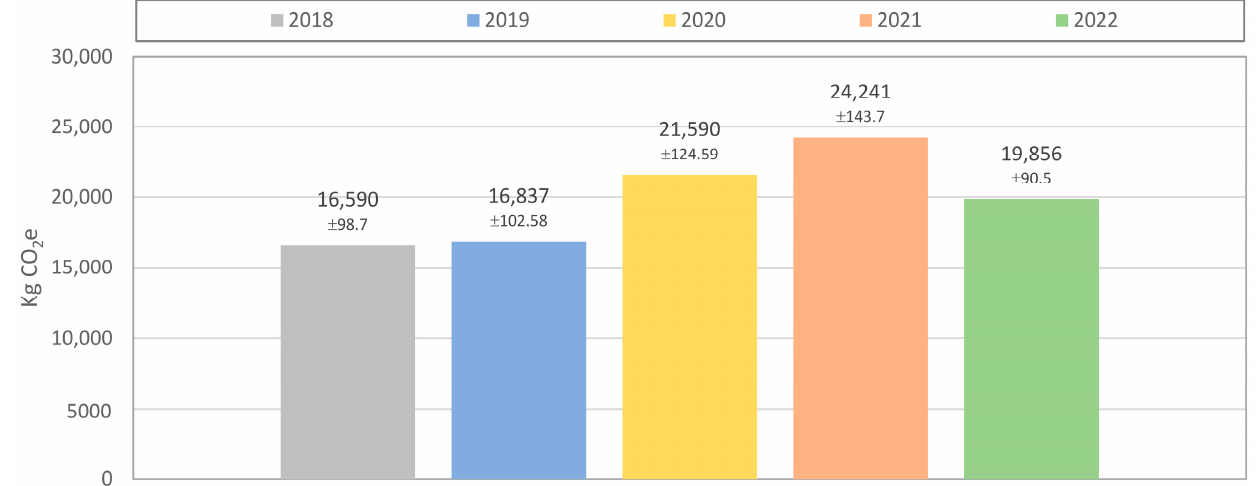
Figure 3. Annual carbon footprint of the total gown consumption.